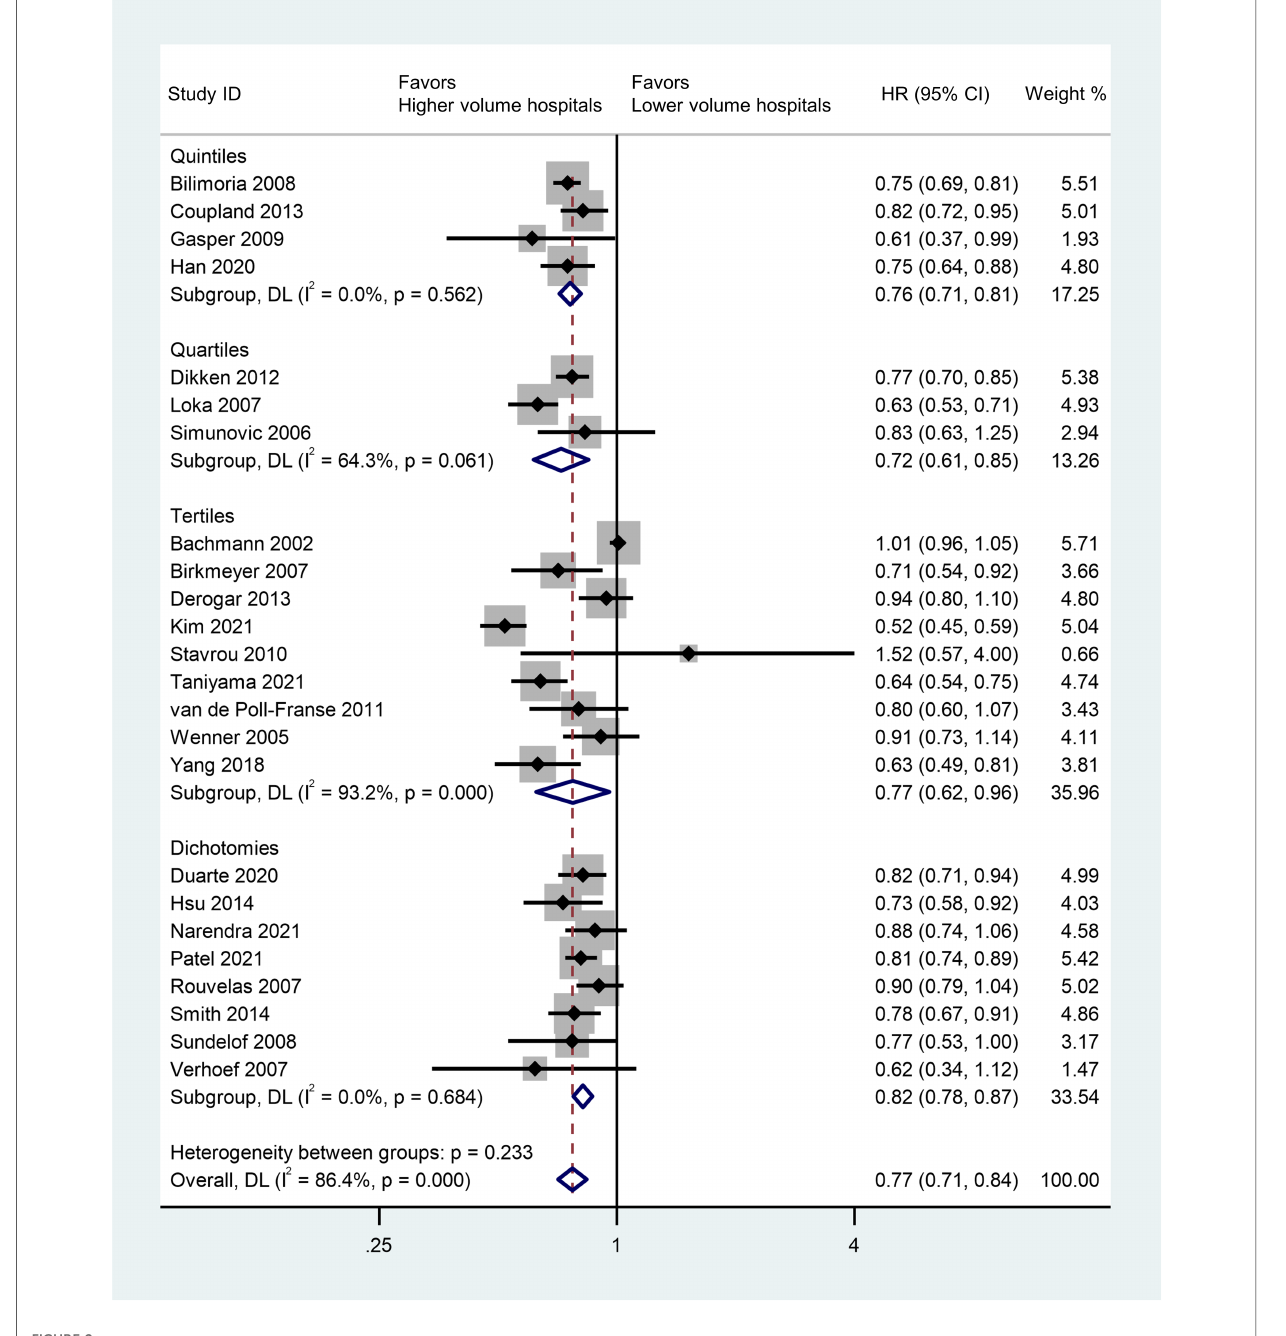
FIGURE 2 Forest plot of long-term survivals following esophagectomy comparing high- with low-volume hospitals (reference) according to volume